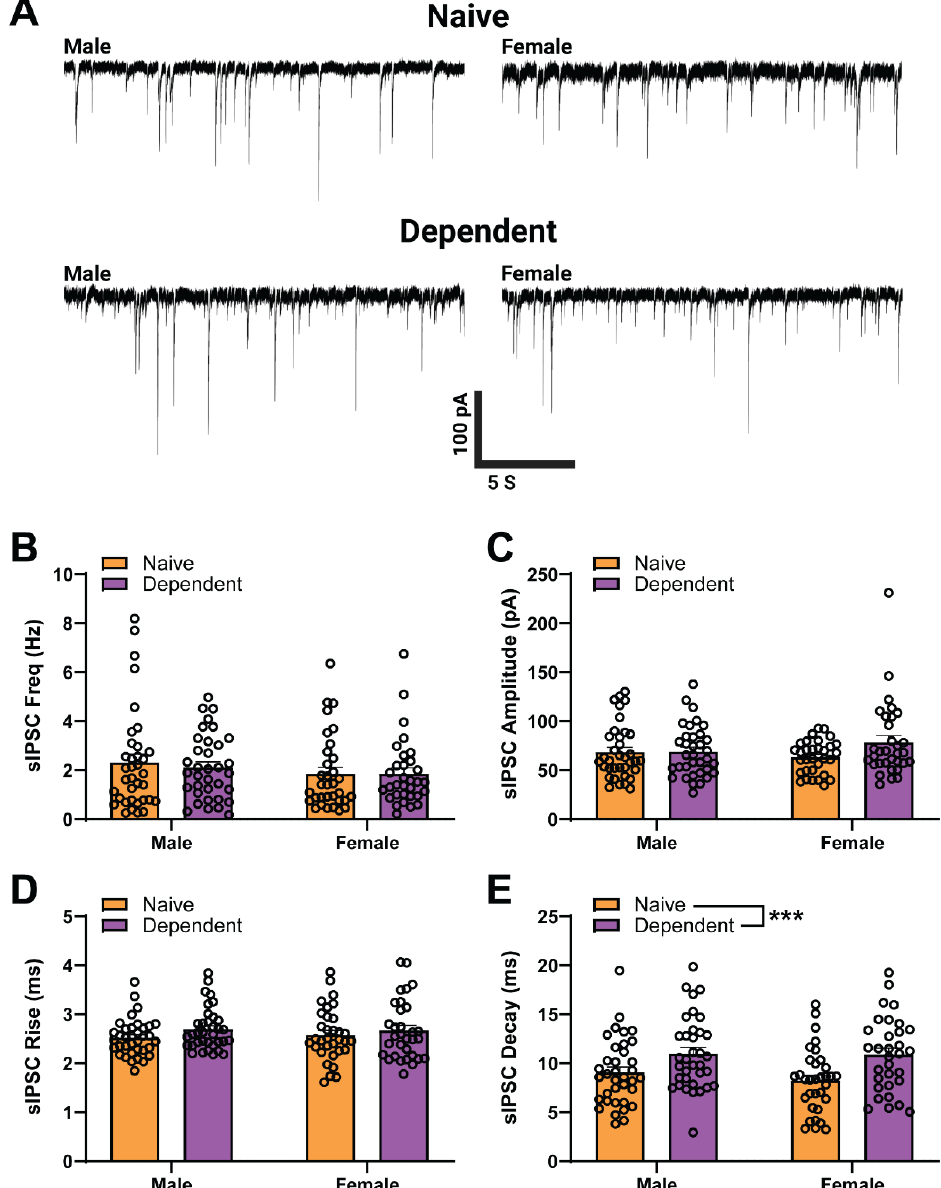
Figure 1. Baseline spontaneous GABAergic transmission in central amygdala (CeA) of males and females. ( A – E ): ( A ) Representative GABA A -mediated sIPSCs from CeA neurons of male ( left ) and female ( right ) rats, either naïve ( upper ) or alcohol dependent ( lower ). There is no effect of Sex or Alcohol Exposure and no interaction effect in CeA baseline sIPSC frequency ( B ), amplitude ( C ), or rise time ( D ). For sIPSC decay time ( E ), there is no main effect of Sex or interaction effect, but there is a main effect of Alcohol Exposure, primarily driven by dependent females with a prolonged decay time (10.88 ± 0.67 ms) compared to naïve females (8.24 ± 0.57 ms). Differences in baseline sIPSC properties are assessed using two-way ANOVA test.; Bars represent Mean ± SEM; *** denotes p < 0.001; n = 31–36 neurons per group; N = 19–25 rats per group.